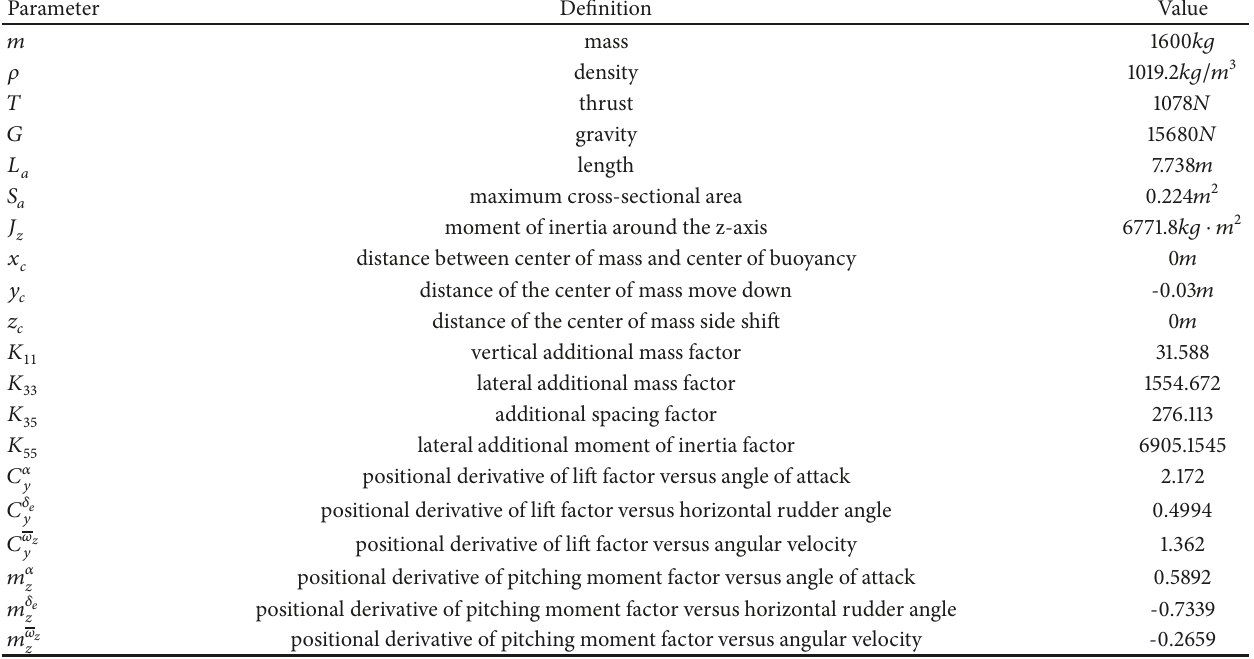
Table 1: The parameters of each AUV.